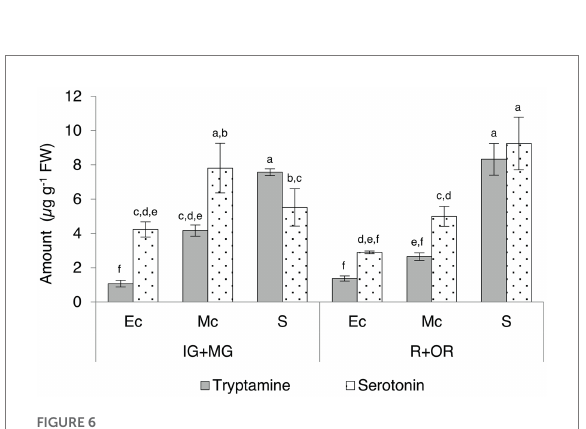
FIGURE 6 Quantities of tryptamine and serotonin detected by UPLC-ESI-MS in the skin (exocarp, Ec), flesh (mesocarp, Mc) and seeds (S) of unripe (IG + MG) and ripe (R + OR) Micro-Tom fruits, expressed as μ g g − 1 FW. Data are means ± SD ( n = 3). Different letters on bars indicate that means are significantly different according to post- hoc Tukey-ANOVA ( p < 0.05). The abbreviations and the position of the samples are explained in Figure 3.